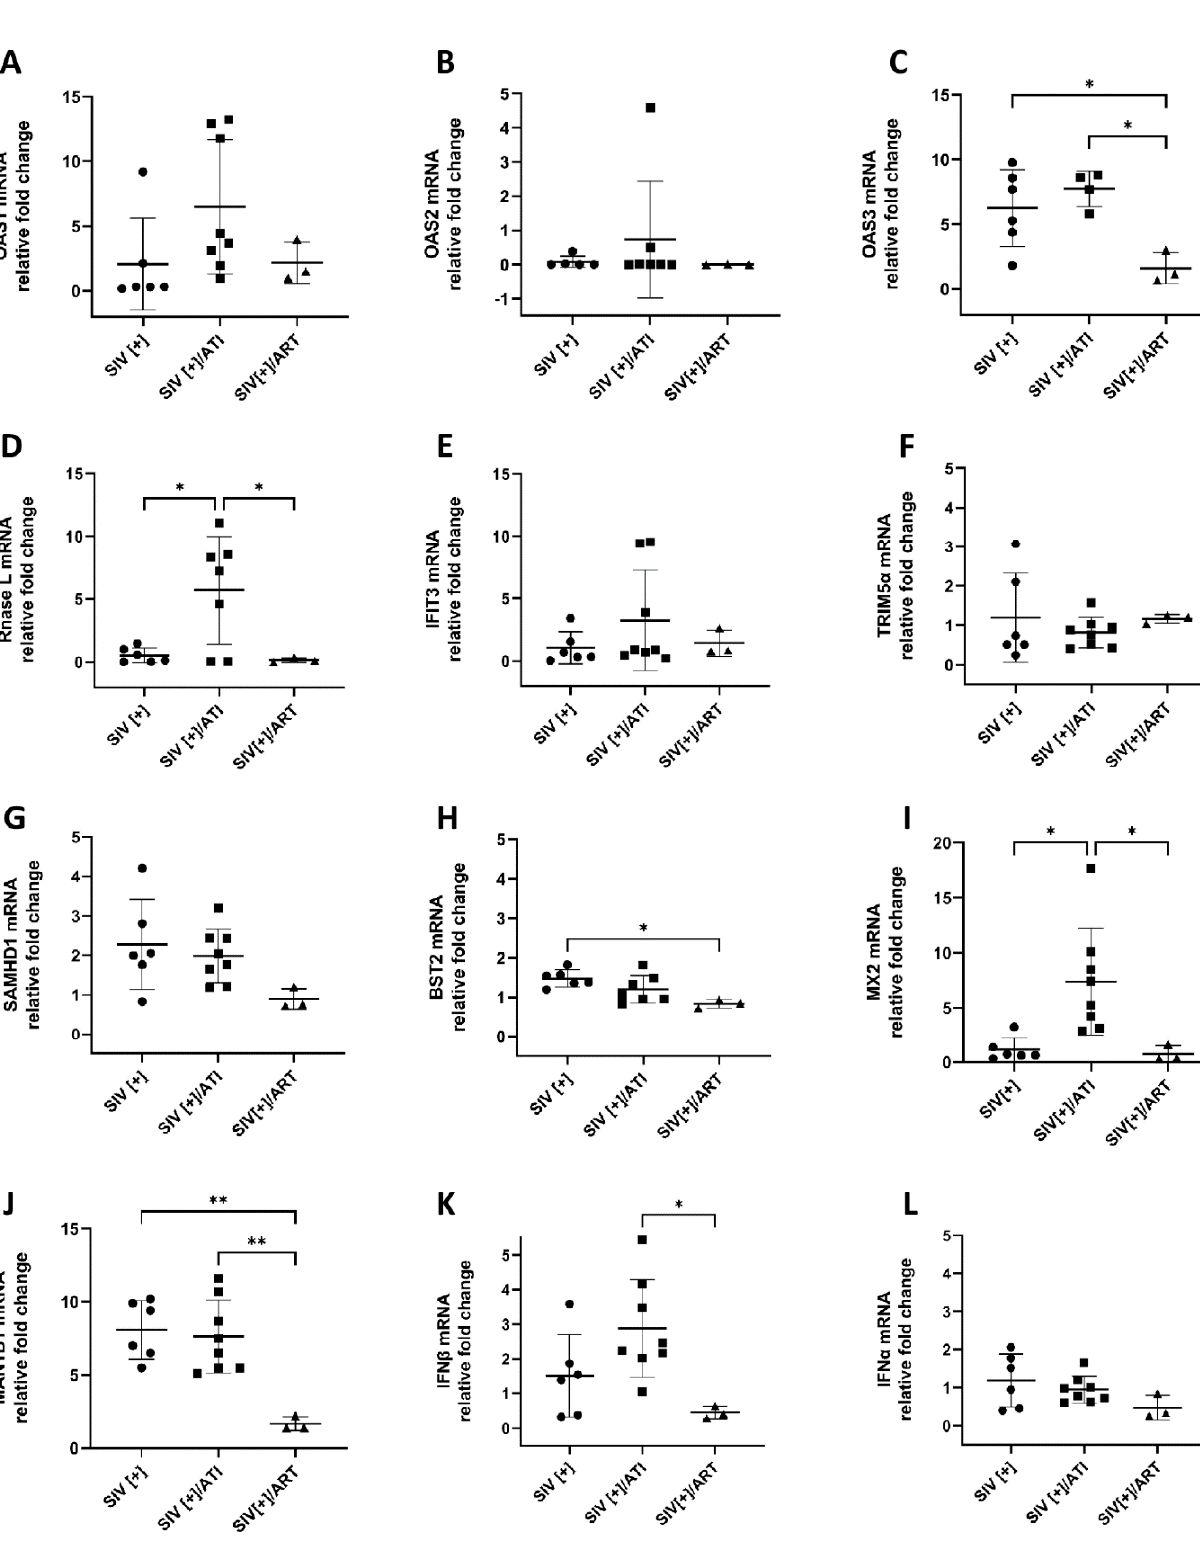
Figure 8. Analyses of RFs in the brains of SIV-infected non-human primates by qRT-PCR . The expression levels of 10 known RFs ( A – J ), as well as IFNA and IFNB1 were measured in three exper- imental groups of SIV-infected Chinese rhesus macaques (SIV[+], SIV[+]/ATI and SIV[+]/ART). The mRNA expression levels are normalized to GAPDH and are reported as the fold change relative to the SIV[+]/ART control group. The horizontal lines represent the mean values and the error bars represent the standard deviation (*, p < 0.05; **, p < 0.01)